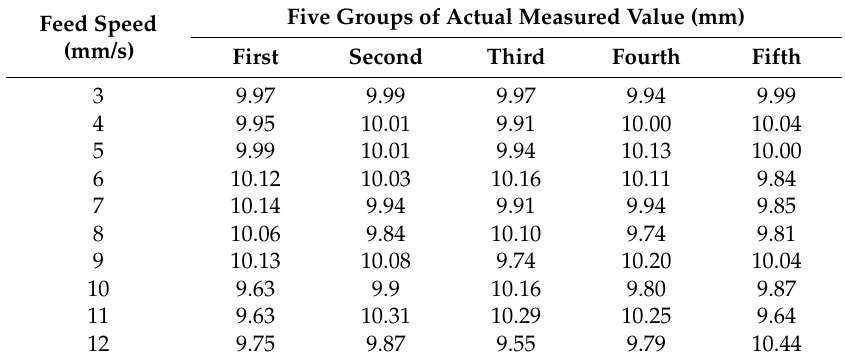
Table 2. The effect of feed speed on the accuracy of measurement: actual measured value. Feed